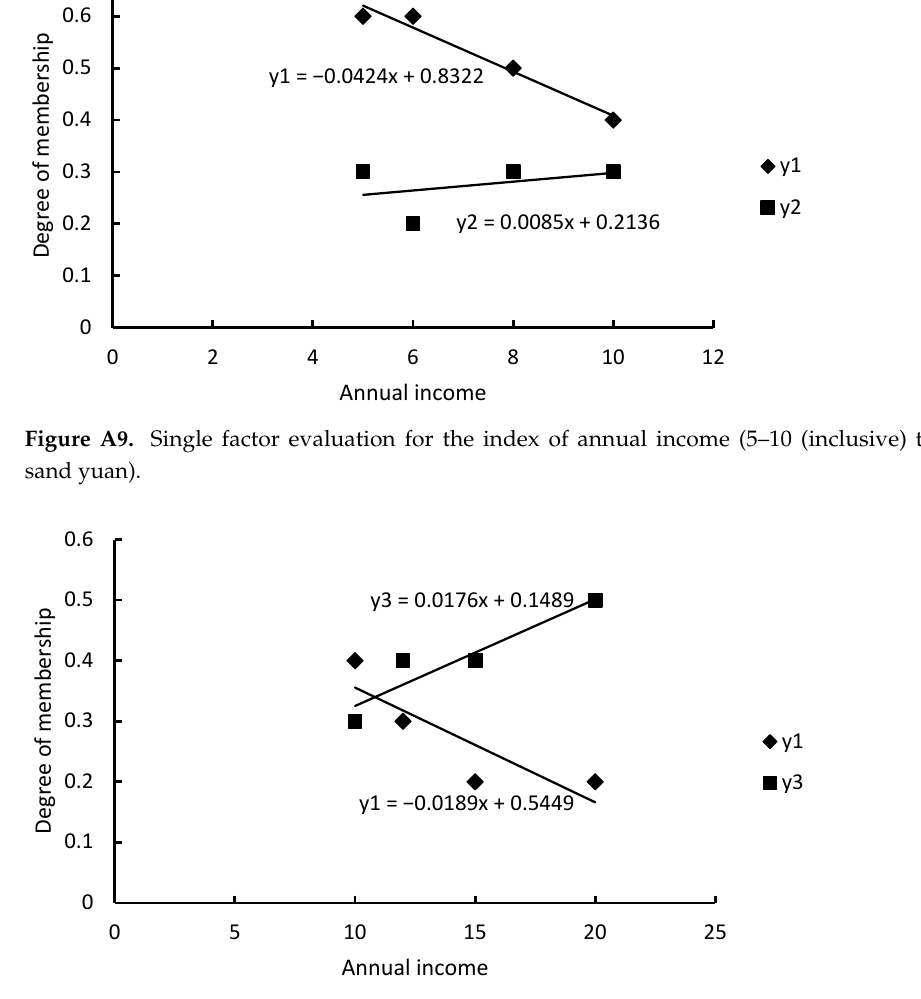
Figure A10. Single factor evaluation for the index of annual income (10–20 (inclusive) ten thou- sand yuan).